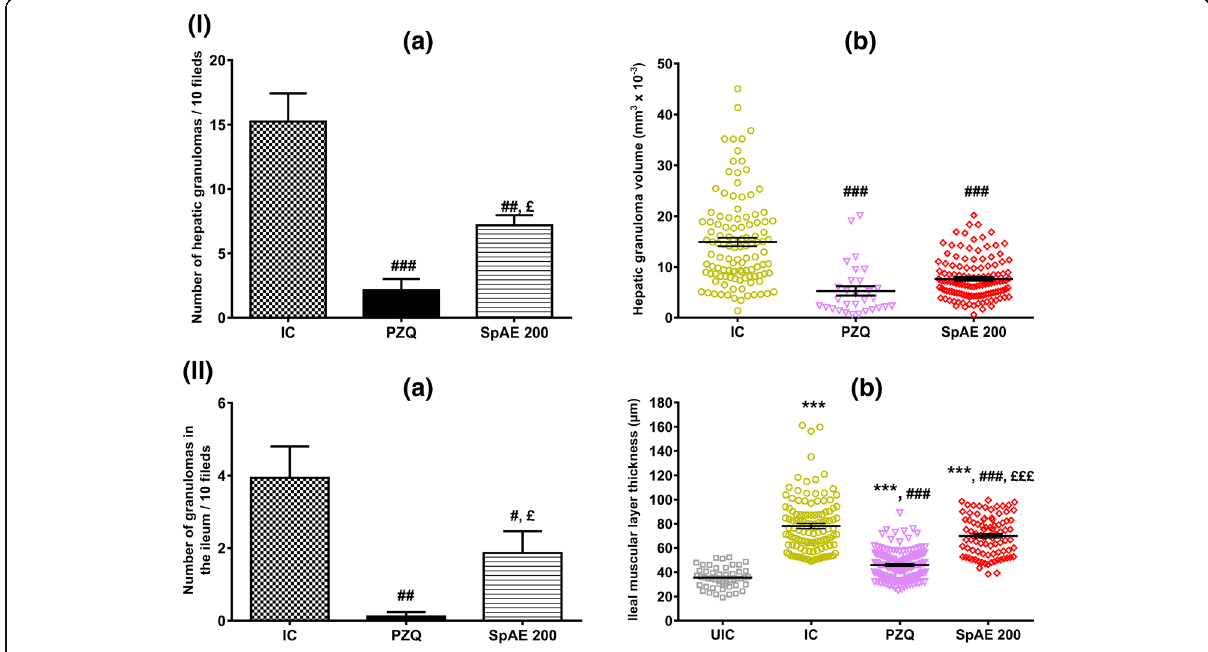
Fig. 2 Effect of oral treatment of Sida pilosa aqueous extract on the morphometry of the liver ( I ) and the ileum ( II ) of Schistosoma mansoni -infected mice. ( a ): number of granulomas; ( b ): volume of granulomas / muscular layer thickness. UIC: uninfected-untreated mice; IC: infected-untreated mice; PZQ: infected mice treated with praziquantel; SpAE 200: infected mice treated with Sida pilosa aqueous extract at 200 mg/kg. Data are expressed as mean± SEM ( n =6). ANOVA followed by Newman-Keuls multiple comparison test was used for statistical analysis. *** p <0.001: values are significantly different from those of uninfected-untreated mice (group UIC). # p <0.05, ## p <0.01, ### p <0.001: values are significantly different from those of infected-untreated mice (group IC). £ p <0.05, £££ p <0.001: values are significantly different from those of infected mice treated with praziquantel (group